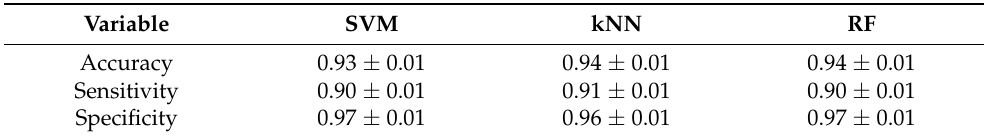
Table 3. Performance metrics for each classifier, SisFall test set for overlapping approach (50% overlapping epochs). All classifiers have been trained on a SisFall set and evaluated using a SisFall test set, from which the metrics have been calculated. Each classifier yielded similarly high classification metrics. The values are mean ± standard deviation.